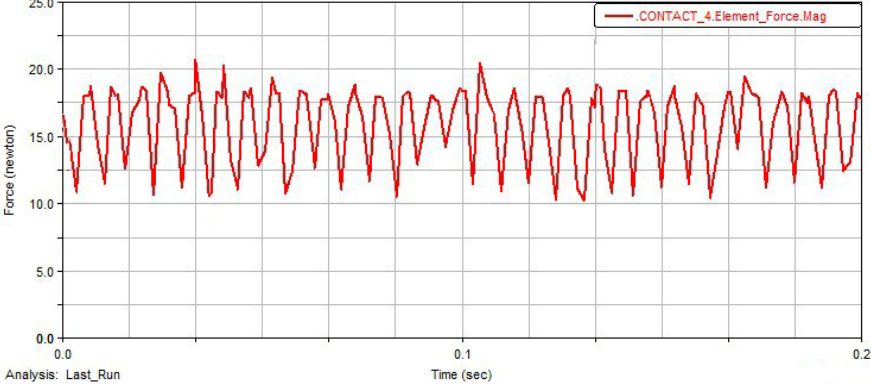
Figure 16. Comparison of slide and stator contact force after stator optimization.